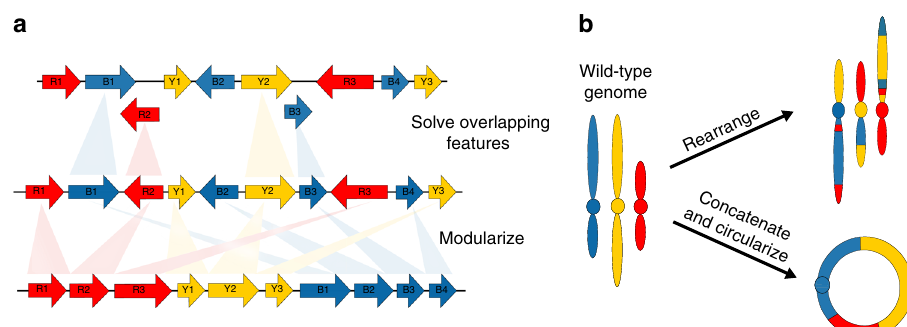
Fig. 2 Restructuring. a Synthetic genomics makes it possible to engineer diverse chromosome structures. At a micro-scale, the arrangement of genetic material within genomic regions can be altered. For example, structural overlaps between adjacent genes can be eliminated (i.e., refactoring) or genes with related functions can be positioned next to each other (i.e., modularization). Such modi fi cations can be implemented chromosome-wide. b On a macro scale, this includes the introduction of gross chromosomal rearrangements, such as deletions, insertion, inversions, and translocations, as well as the modi fi cation of chromosome number and